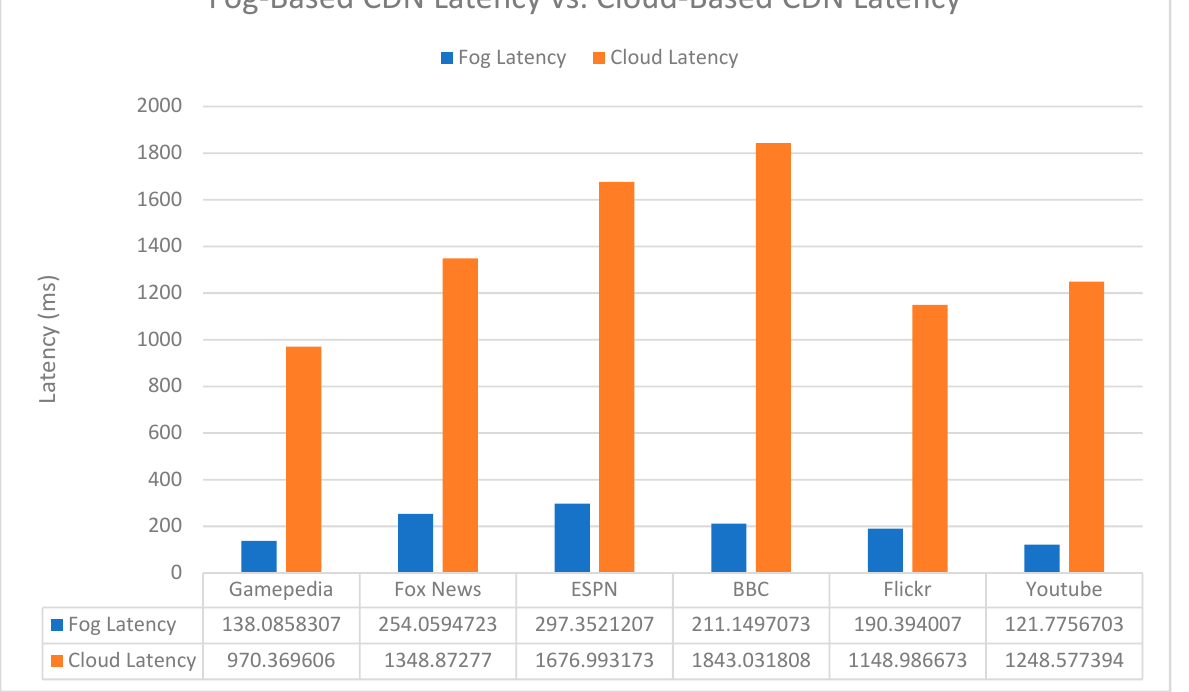
Figure 8. Fog-based CDN latency vs. cloud-based CDN latency.